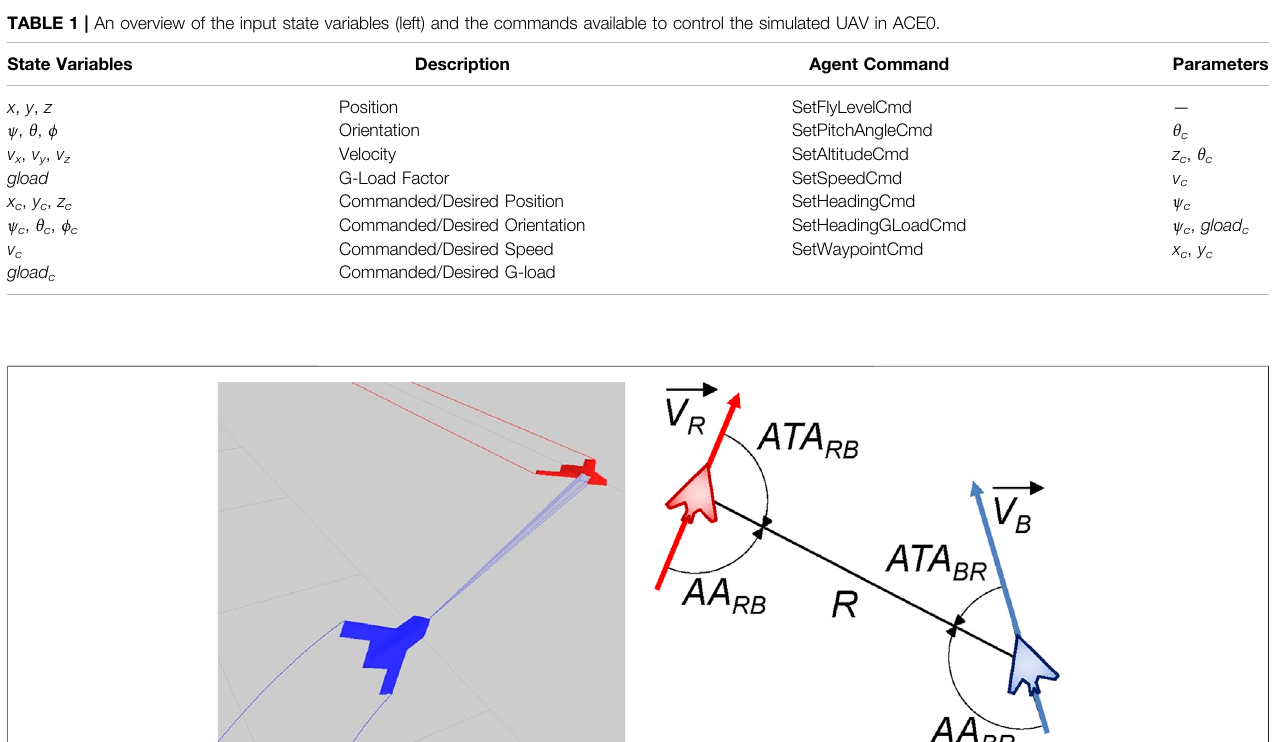
FIGURE 2 | (Left) 3D visualisation of a two UAVs (blue and red) from a run generated by the ACE0 simulation environment. (Right) Relative angle conventions between the two UAV as implemented in